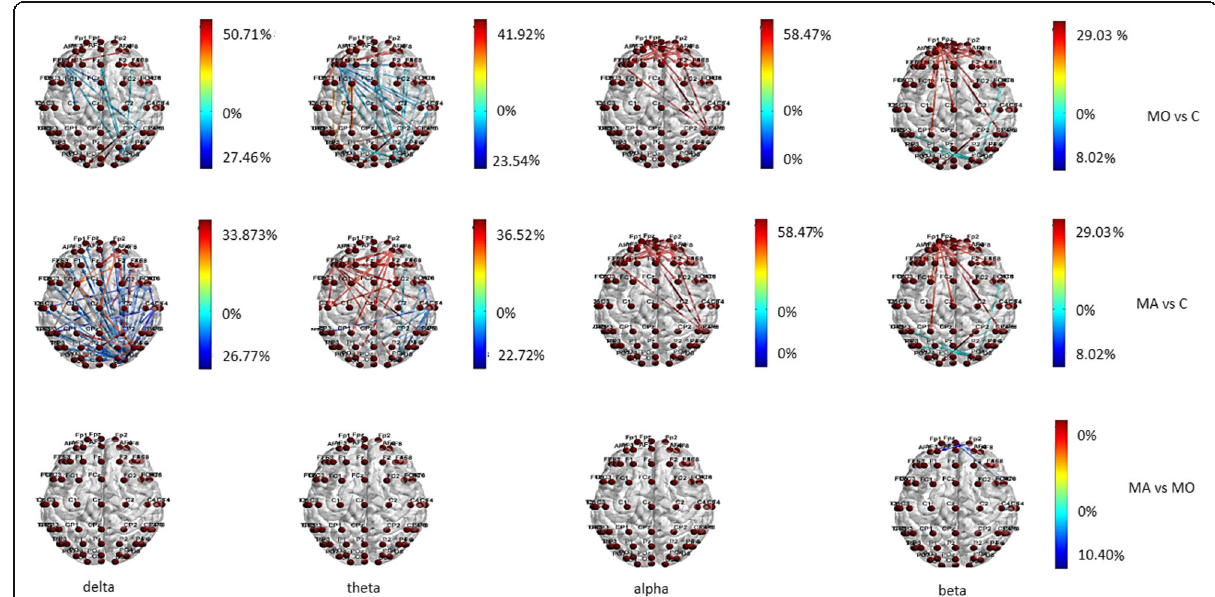
Fig. 5 Statistical differences in information transfer and their relative directions among nodes during 2 cpd spetial frequency are depicted in the Migraine with aura (MA), Migraine without aura (MO) and Controls (C) groups . Hot colors refer to a statistical prevalence of information transfer in the first element of the comparison, and cold colors for the vice-versa. The color intensity is graduated on the relative percent difference. (further data on statistical analysis are available in the Additional file 1: section, chapter